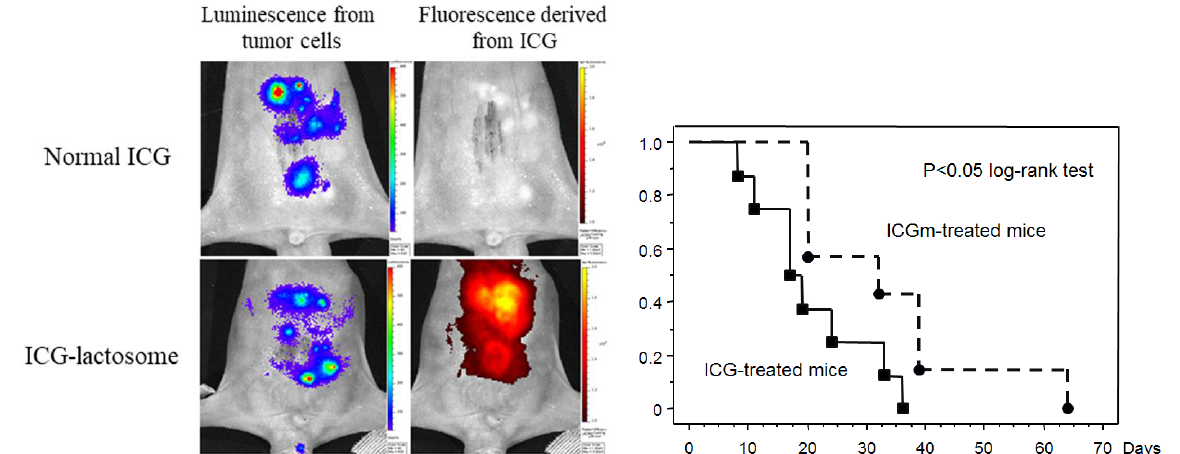
Figure 6. Photodynamic therapy of peritoneal dissemination in gastric cancer. ( Left ) Comparison between ICG and ICG-lactosomes in terms of luminescence and ICG-fluorescence from tumors. ( Right ) Survival rate after photodynamic therapy (PDT) in mice treated with ICG or ICG-lactosomes. PDT with ICG-lactosomes resulted in significantly improved survival rates compared to that with ICG alone. (Reproduced from Tsujimoto et al. [9]).